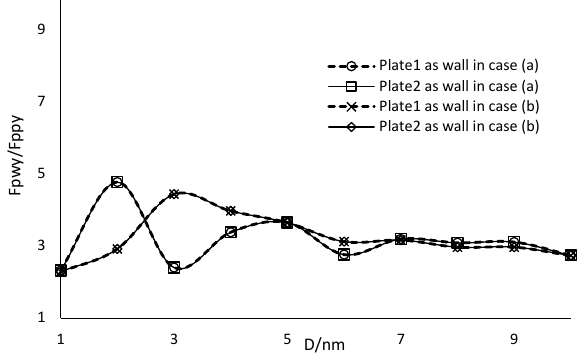
Figure 10. Comparison of the calculated force of different choices based on projection procedure.